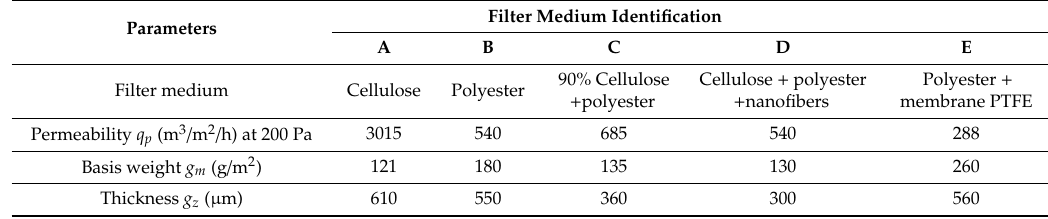
Table 1. The parameters of the tested filter media based on the data provided by the manufacturer. Parameters